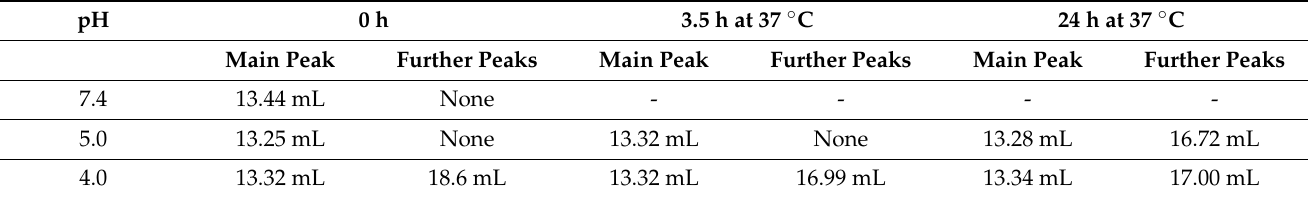
Table 1. Folding stability at acidic pH evaluated by SEC (Size Exclusion Chromatography).